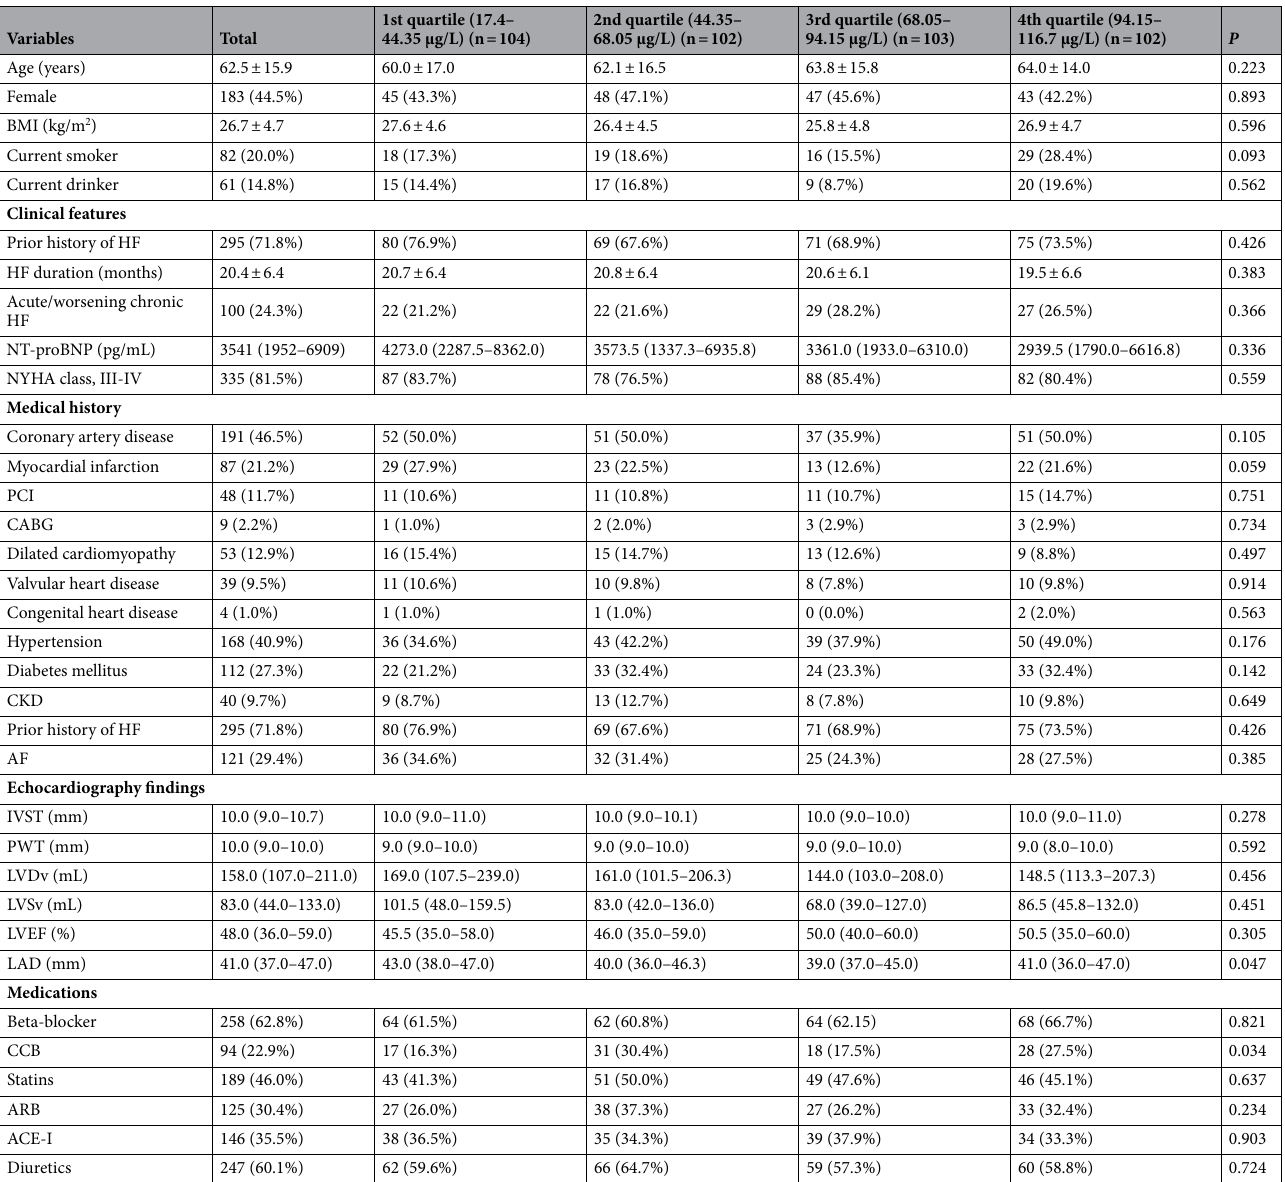
Table 1. Baseline characteristics of the study population stratified by quartile of serum Se concentration. Data are presented as mean (standard deviation), median (interquartile range), or n (%). BMI body mass